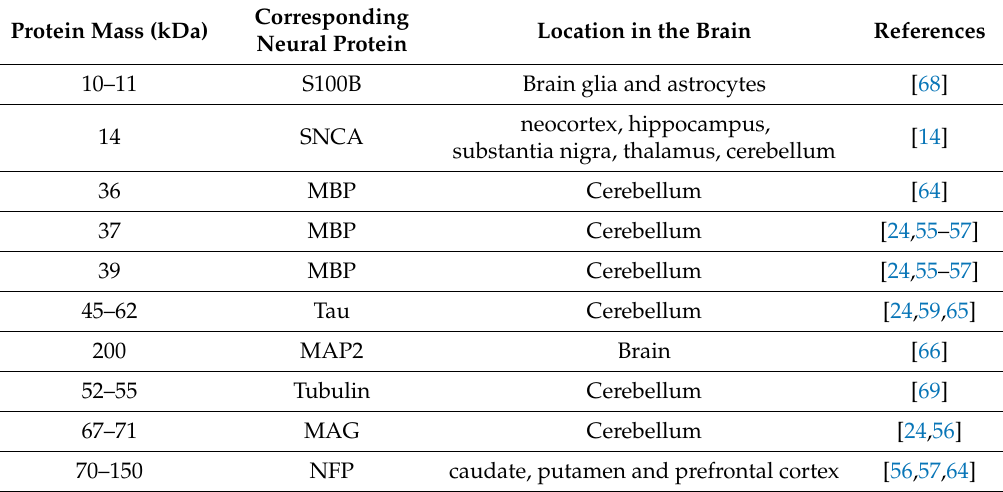
Table 5. Assignment of neural protein identity by molecular mass (in